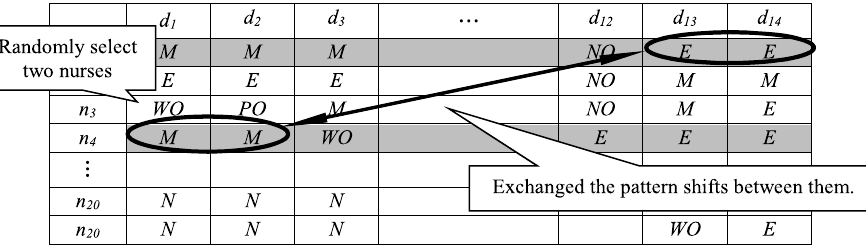
Figure 4. The possible representation of solution W ( p ) for a partial solution.